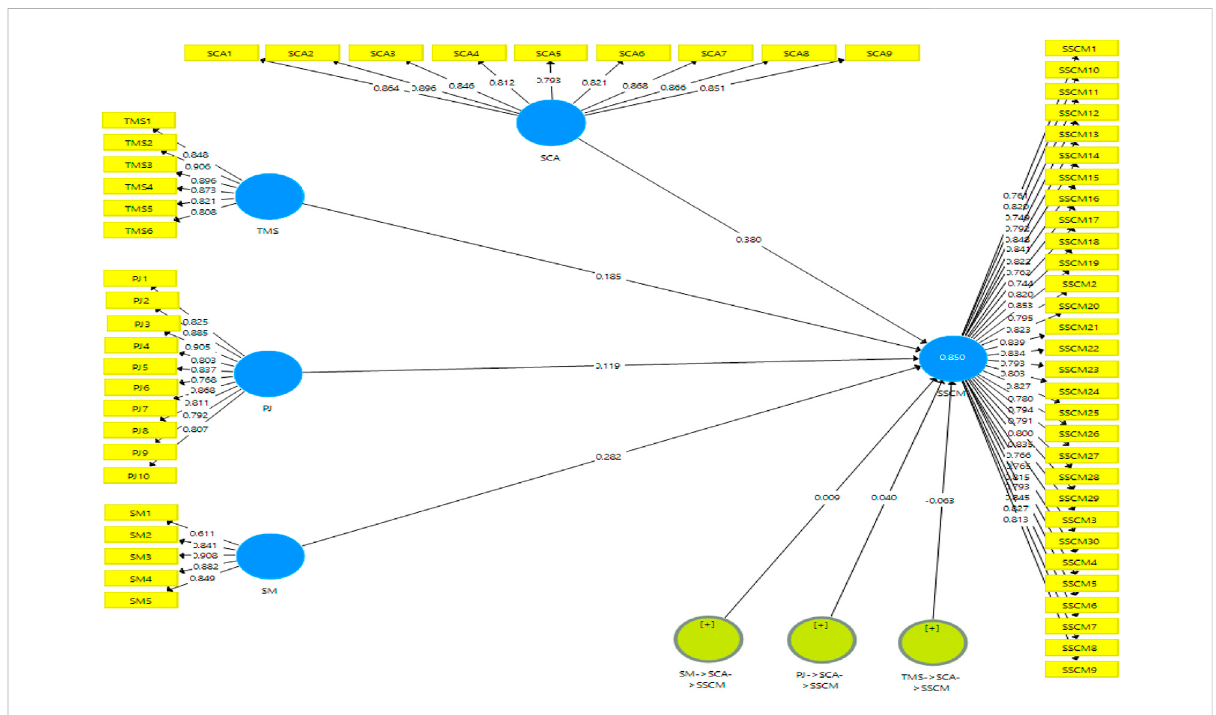
FIGURE 2 Measurement